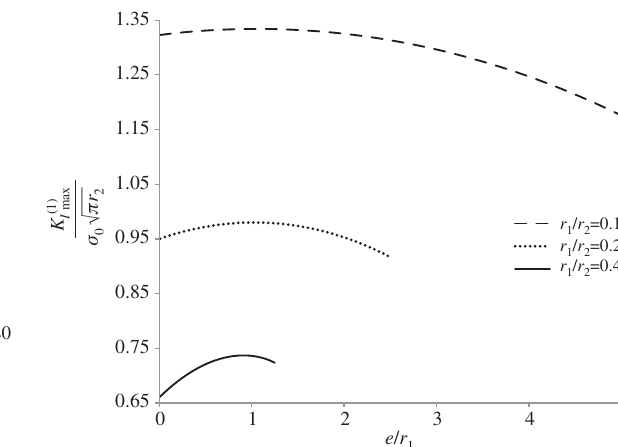
Figure 6: Variation of the maximum inner stress intensity factor in terms of eccentricity for the three cases of r